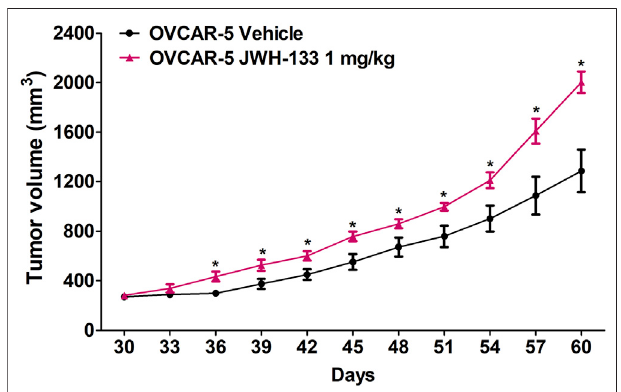
FIGURE 2 | Increase in ovarian (OVCAR-5) cancer ectopic xenograft tumor growth following chronic daily administration of JWH-133 (1 mg/kg) relative to vehicle group in immunocompromised SCID-SHO female mice. JWH-133 (1 mg/kg i.p.) chronic daily administration for 30 days starting on day 30 of tumor growth produced an increase in OVCAR-5 ectopic xenograft ovarian cancer growth in immunocompromised SCID-SHO female mice relative to the vehicle treated group. Symbols represent the means ± SEM. (OVCAR-5 tumor growth in SCID-SHO female mice receiving vehicle, n = 8 SCID-SHO females; OVCAR-5 tumor growth in SCID-SHO female mice receiving JWH-133, n = 8 SCID-SHO females). * p < 0.044 for JWH-133 (1 mg/kg (repeated measures one-way